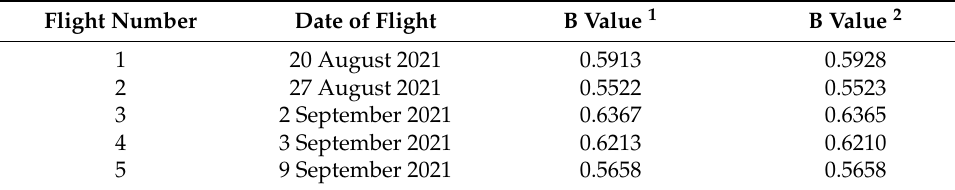
Table 3. B value results.